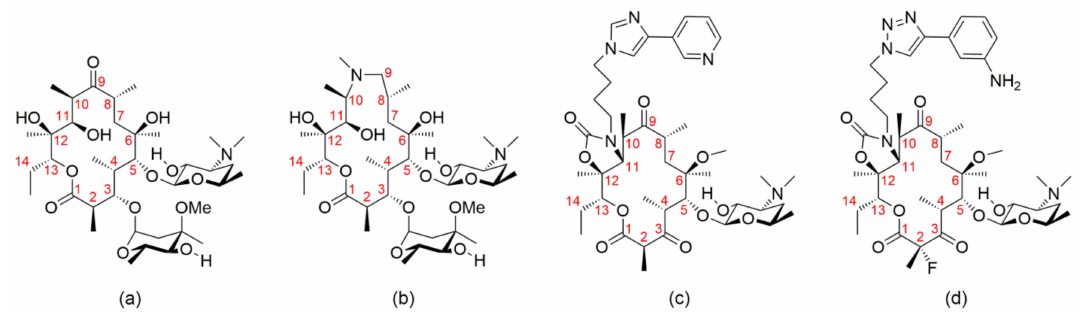
Figure 1. Representatives of four macrolide generations: ( a ) Erythromycin A; ( b ) Azithromycin; ( c ) Telithromycin; ( d ) Solithromycin with atom numbering of the macrolactone